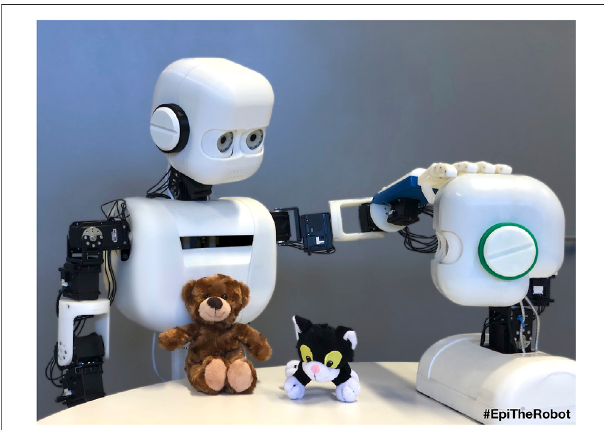
FIGURE 1 | Two versions of the humanoid robot Epi. The robots are designedtoclearly showthatthey aremachinesbut incorporates anumberof antropomorphic feature such as the general shape of the body with a torso, two arms and head together with two eyes with animated pupils and hands with fi ve fi ngers. Although the range of motion is limited compared to a human, the available degrees of freedom re fl ects the main joint of the human body. The version to the right in the fi gure uses a simpli fi ed design without arms and is used for studies of human-robot interaction.